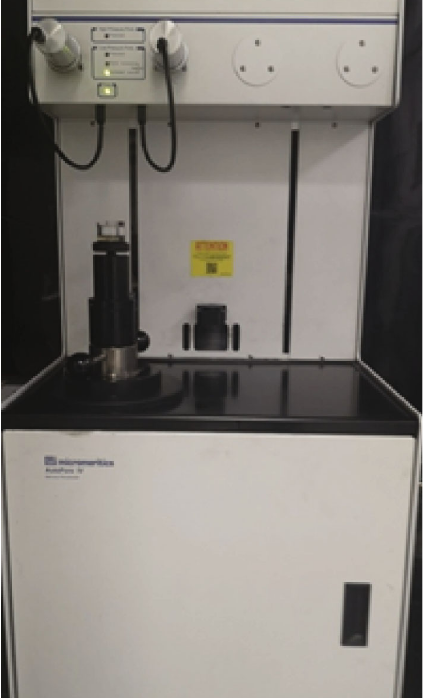
Figure 5: The 9500-model automatic mercury injection of American Mike